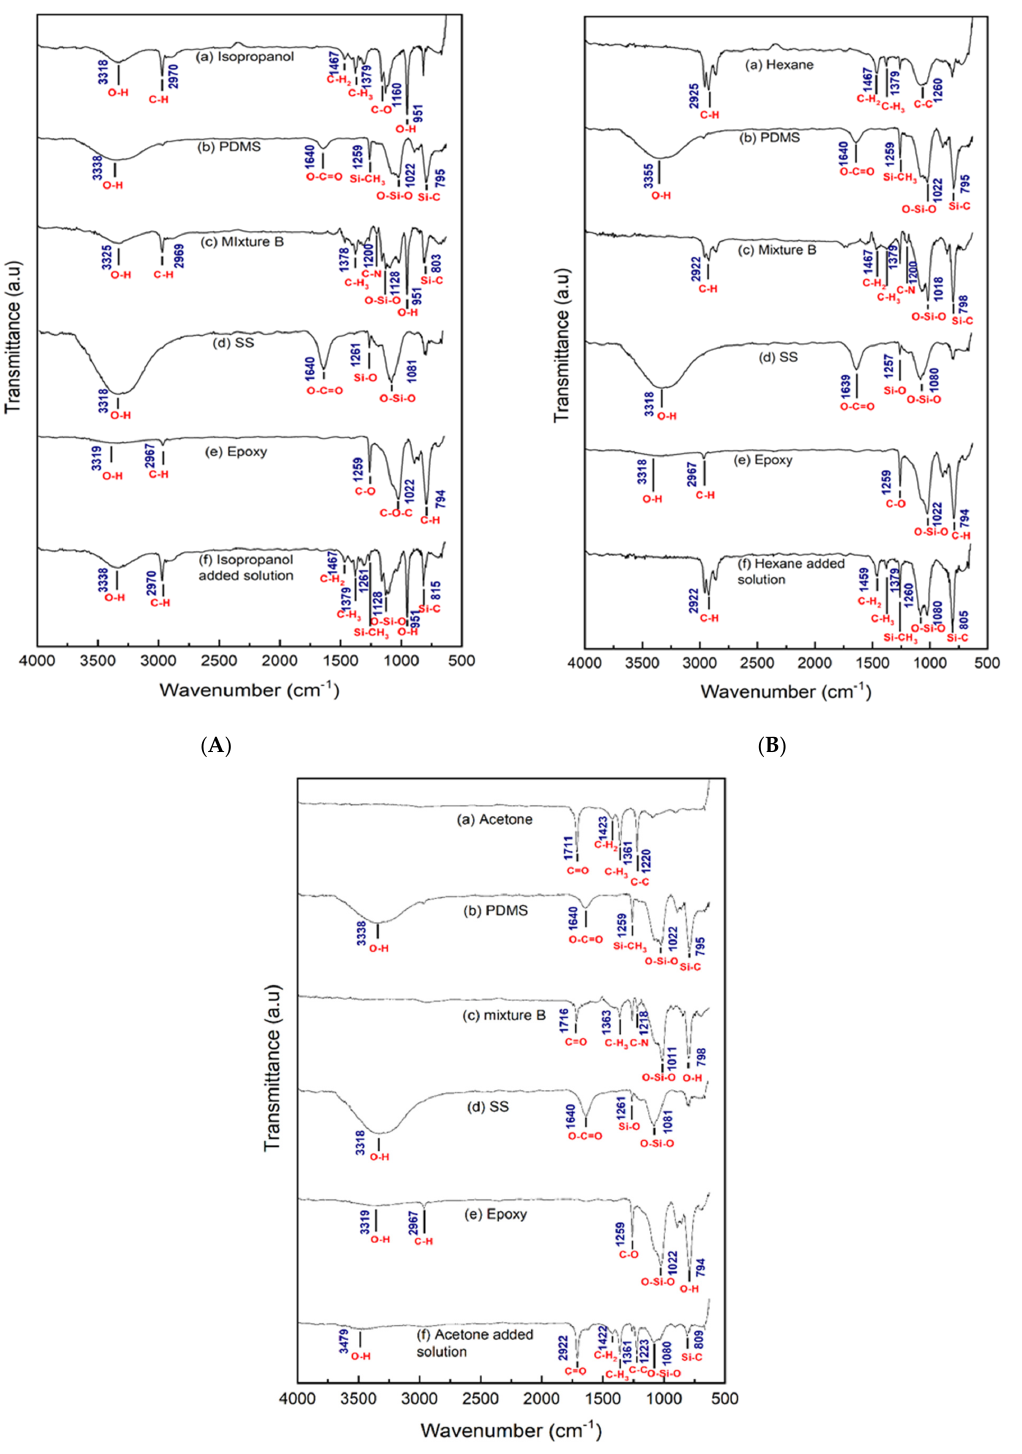
Figure 3. FTIR spectra for ( A ) isopropanol-added solution, ( B ) hexane-added solution, ( C ) acetone- added solution and their respective